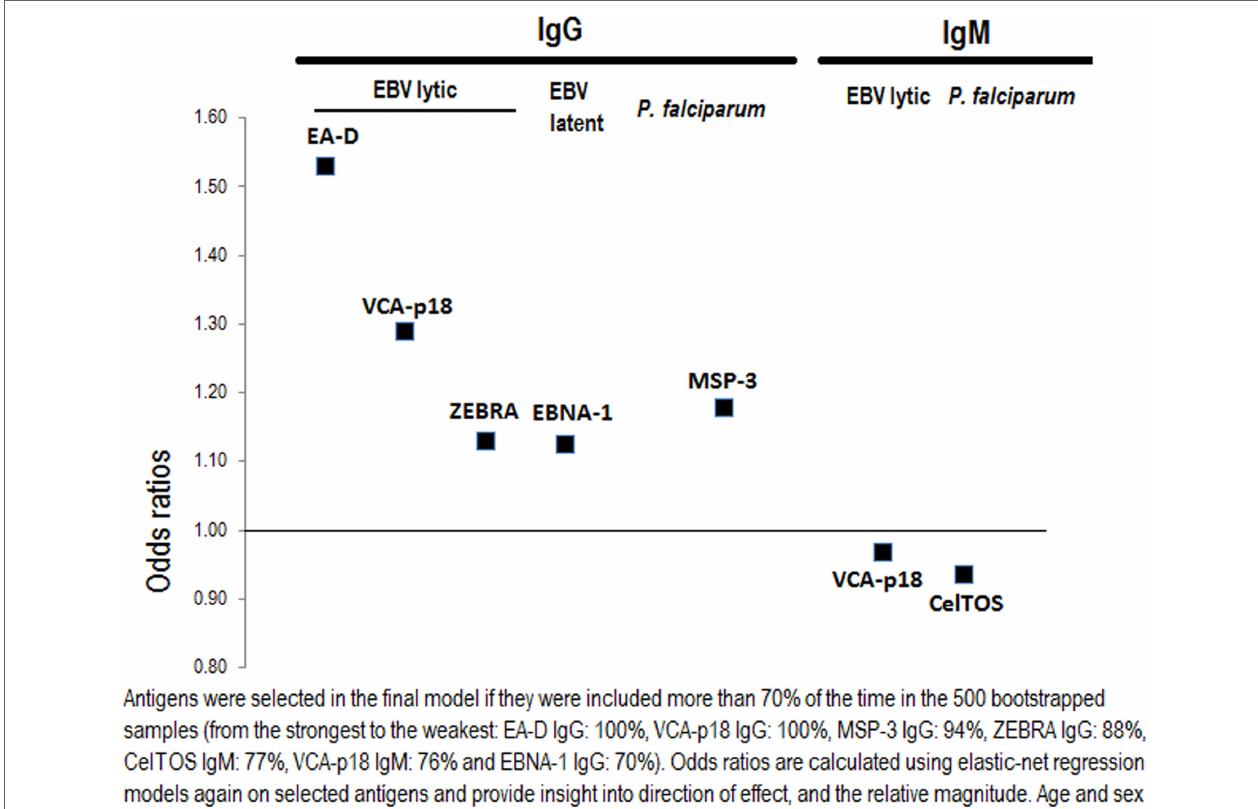
FigUre 4 | Selecting important Epstein–Barr virus (EBV) and Plasmodium falciparum antigen-specific antibodies for endemic Burkitt lymphoma using elastic-net penalized regression